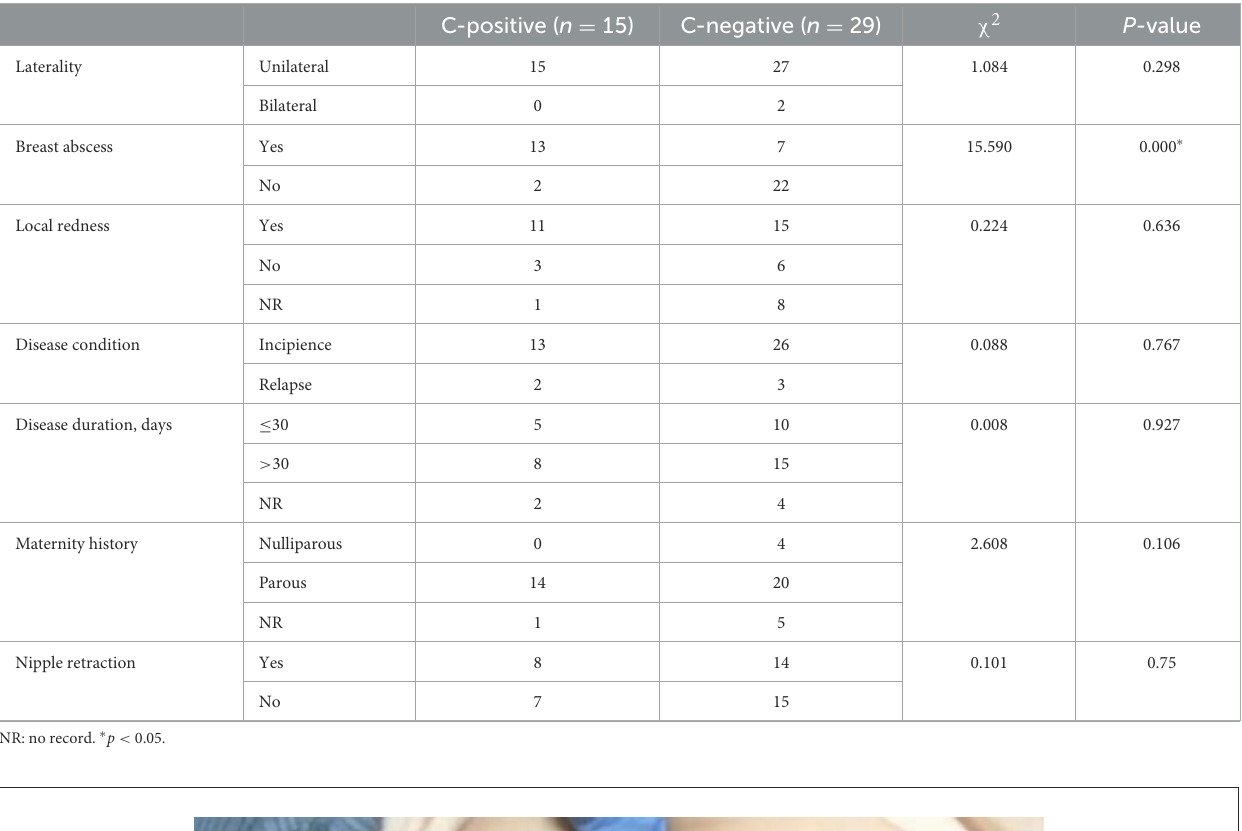
TABLE 6 Clinical characteristics